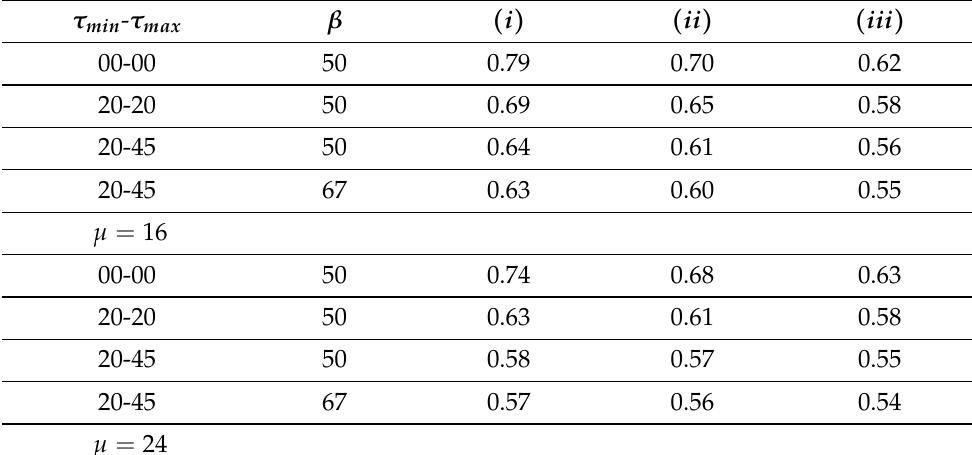
Table 1. The two tables display the Gini coefficients for the models whose minimal and maximal tax rates τ min and τ max and welfare coefficient β are as in the first column, in the cases ( i ) , ( ii ) or ( iii ) as in the first row. The top table refers to total income µ = 16 and the bottom table to total income µ =